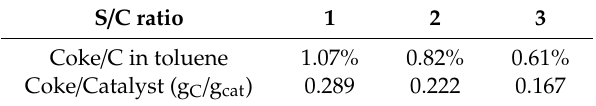
Table 6. Toluene conversion to coke deposited on the catalyst at di ff erent S / C ratios. S / C